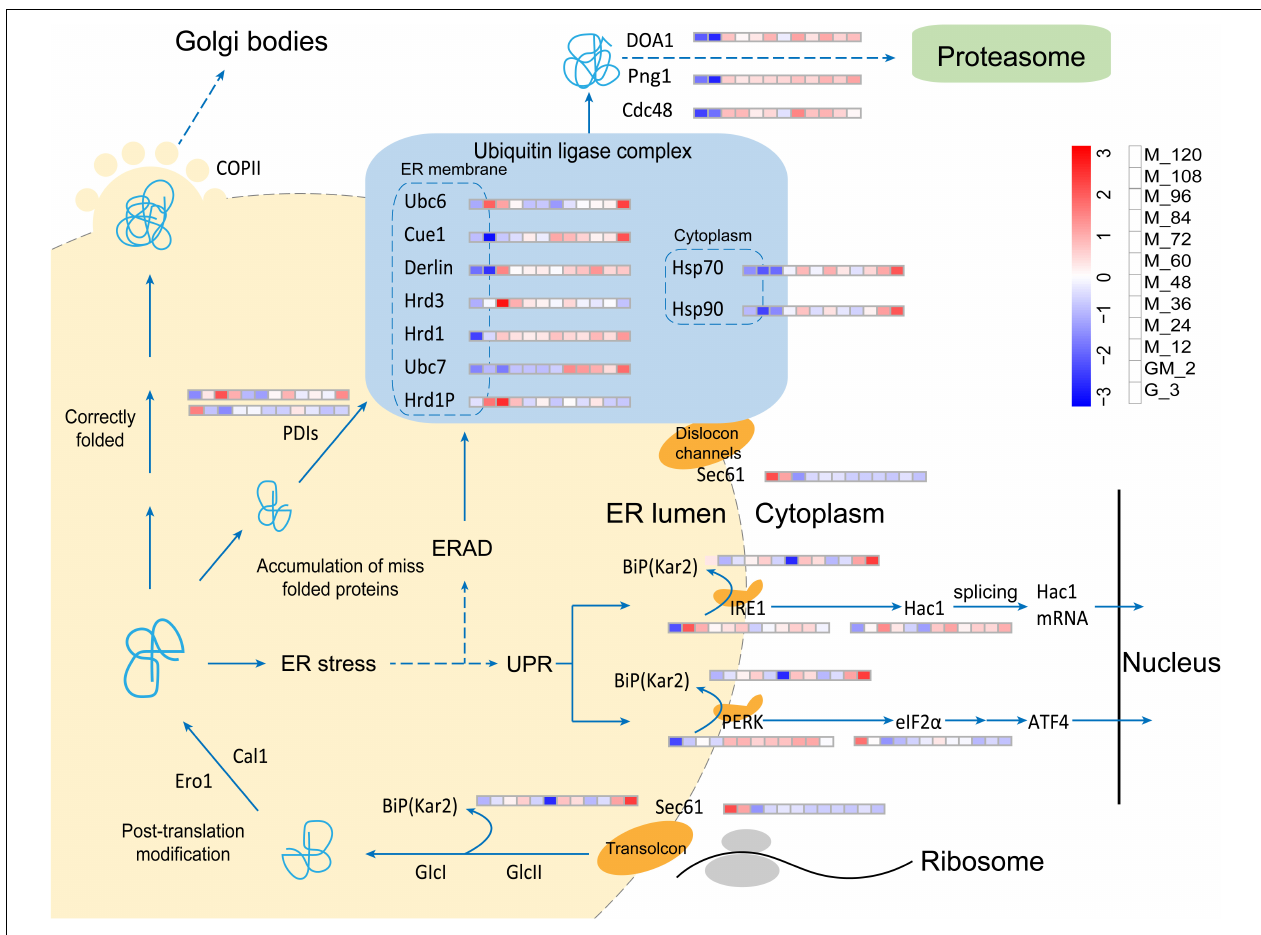
FIGURE 6 | Changes in proteins involved in the UPR and ERAD